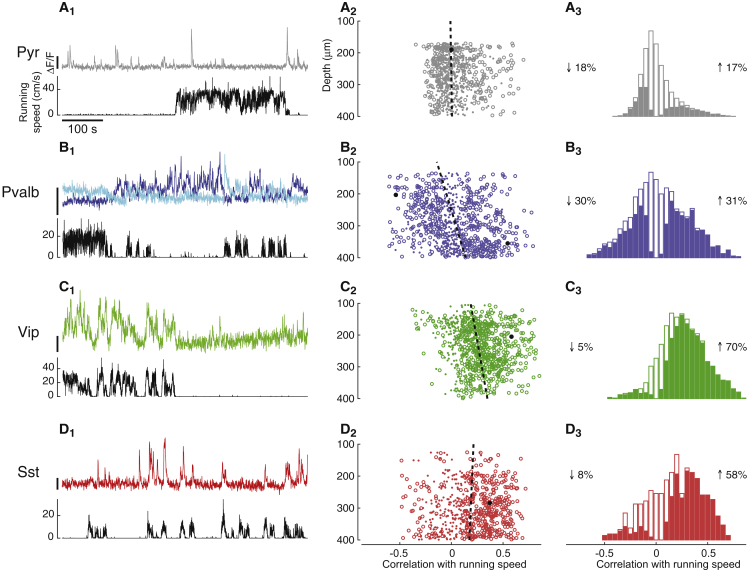
The Effects of Locomotion on Baseline Activity Depend on Cell Type and Depth(A1) Fluorescence of representative L2/3 pyramidal neuron (top) and simultaneous running speed trace (bottom).(A2) Correlation coefficient of recorded pyramidal cells with running speed plotted versus cell depth. Circles represent cells with significant correlations at p < 0.05 (shuffle test); dots represent cells with insignificant correlations. For clearer visualization, we plotted only a random subsample of 800 of genetically identified Pyr cells. Dashed line represents fitted dependence of correlation versus depth. Black circle indicates example cell shown in (A1).(A3) Histogram of correlation coefficients of all pyramidal cells. Solid bars indicate significant correlations at p < 0.05 (shuffle test). Values left and right of the histogram represent the percentage of cells with a negative or positive correlation, respectively.(B) Similar analysis for Pvalb neurons. The two traces in (B1) (top) show fluorescence traces of representative Pvalb cells of upper and lower L2/3 (blue and cyan, respectively). The average correlation with speed was slightly negative (ρgray=−0.05±0.03, SE) among Pvalb cells in superficial L2/3 (depth < 300 μm, n = 843) and weakly positive (ρgray=0.11 ±0.04, SE, n = 831) in deeper L2/3.(C) Similar analysis for Vip cells.(D) Similar analysis for Sst cells.